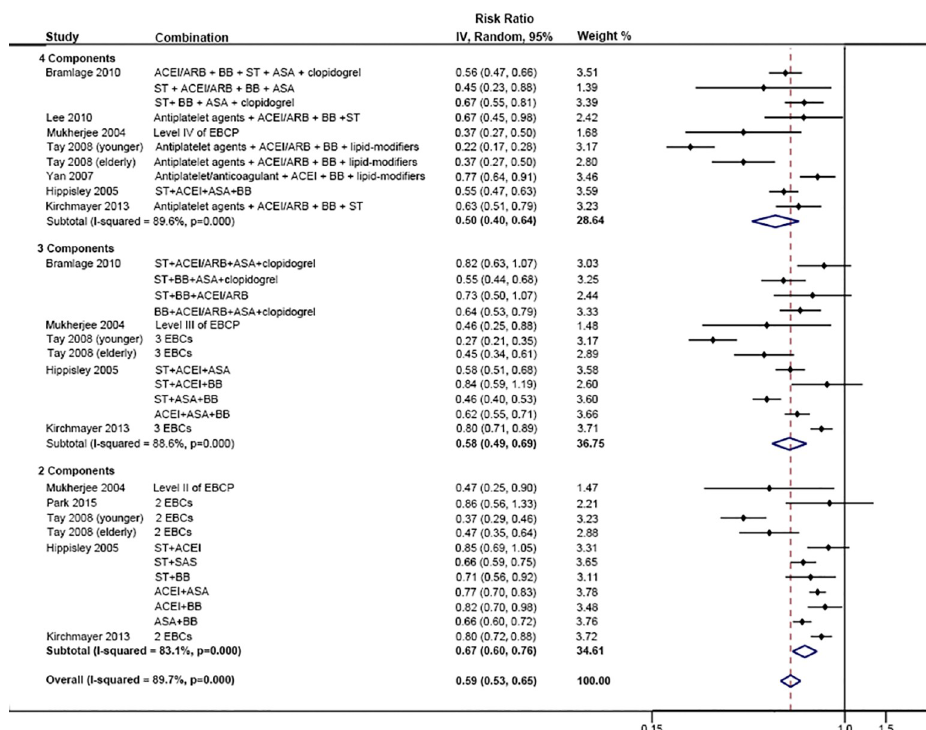
Fig 3. Comparison: Combination therapy of different numbers of components versus 0–1 component, Outcome: All-cause mortality.